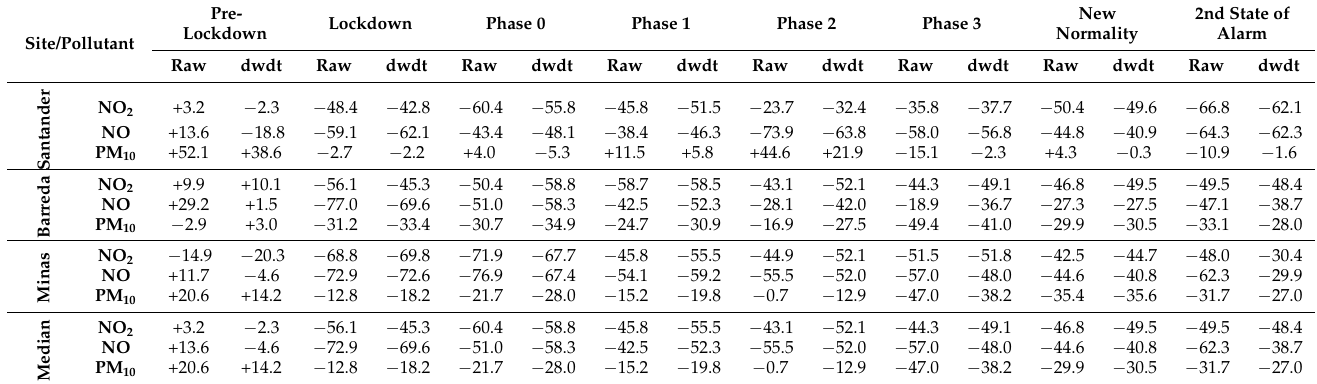
Table 2. Change (%) in pollutant concentrations at traffic sites for each period in the region under study, using raw and normalised data